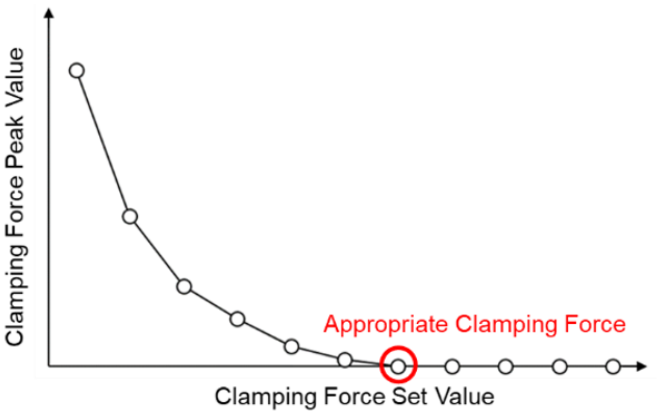
Figure 6. Appropriate clamping force set value [20].